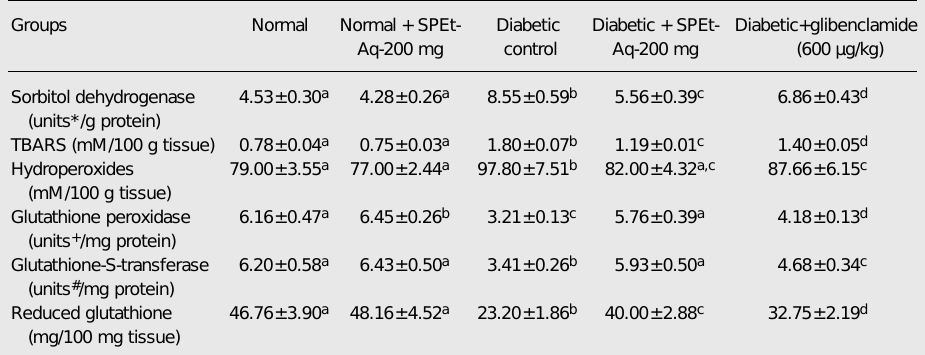
Table 4. Effect of administration by gavage of Scoparia dulcis extract on the activities of sorbitol dehydrogenase, thiobarbituric reactive substances (TBARS), hydroperoxides, glutathione peroxidase, glutathione-S-transferase, and reduced glutathione (GSH) in the liver of normal and diabetic